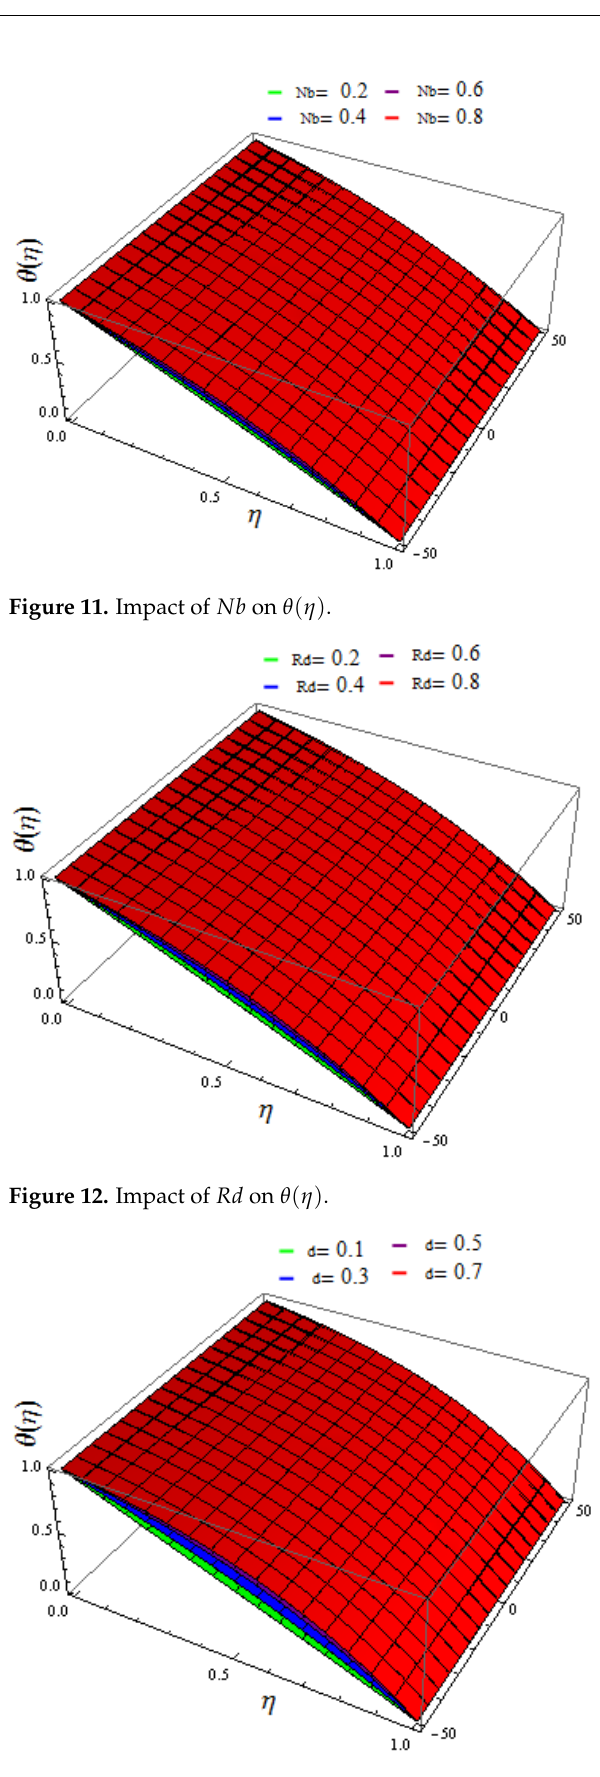
Figure 13. Impact of 𝑑 on 𝜃(𝜂) .